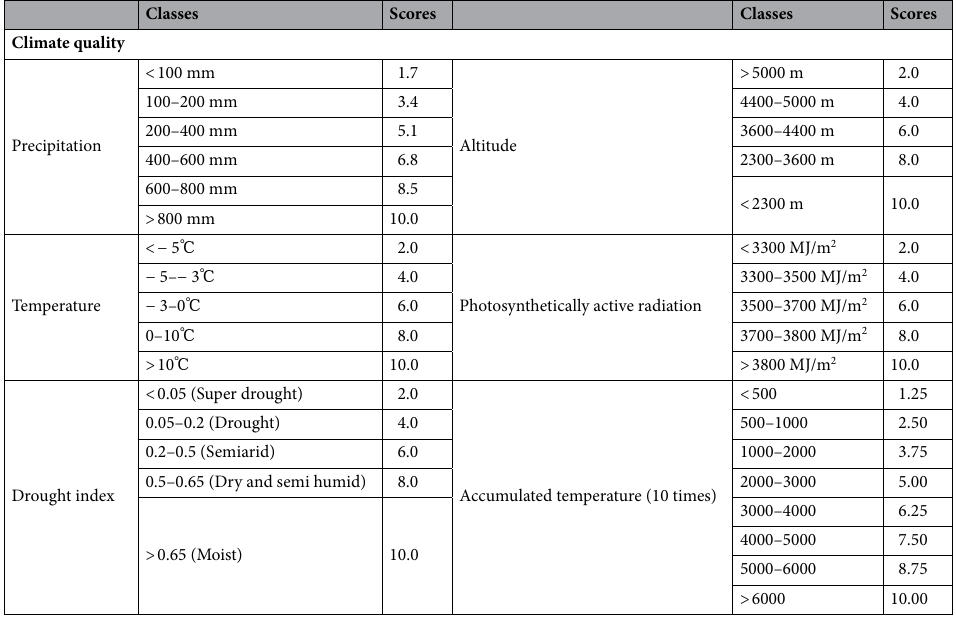
Table 2. The scores of various indexes in the climate quality of the